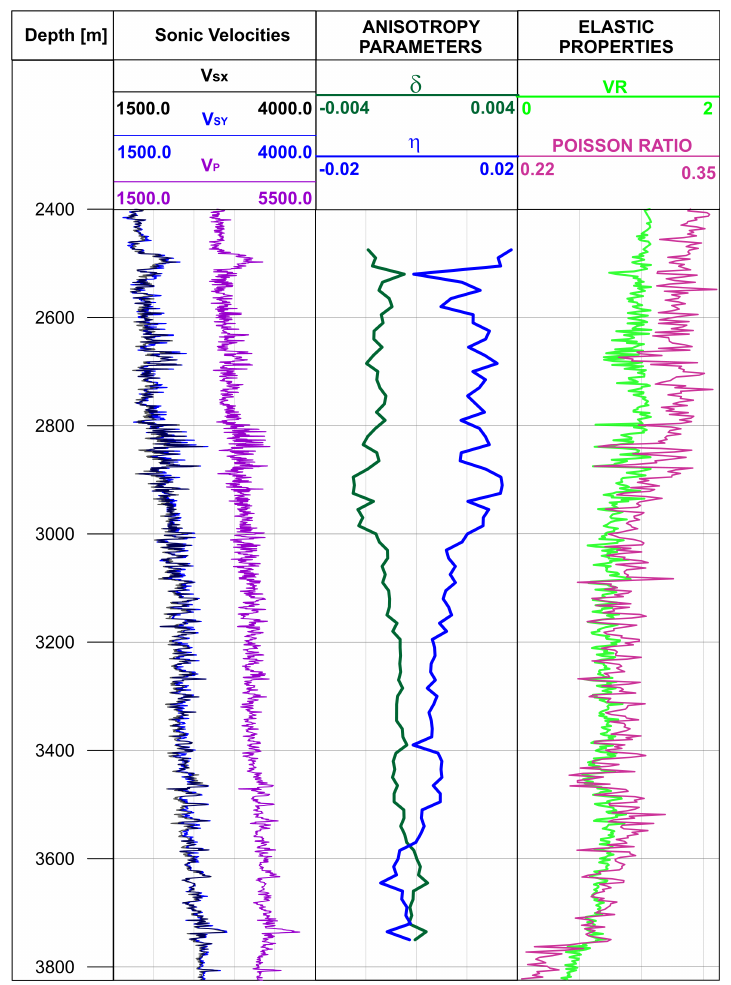
Figure 17. Comparison of sonic V SX , V SY , and V P velocities ( the first block ); δ and η from VSP inversion ( the second block ); and V r with Poisson ratio ( the third block